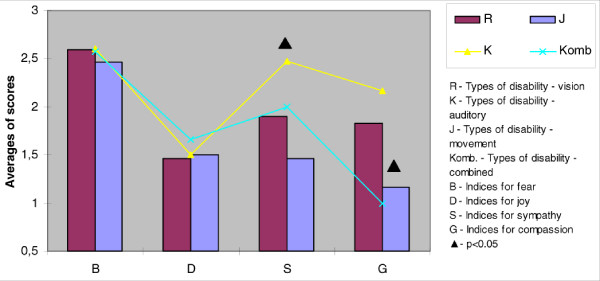
The emotion component of schoolchildren with disabilities according to indices. The indices (fear, joy, sympathy, compassion) of the disabled respondents' emotions towards their peers with disabilities, with relation to the type of disability (vision, movement, auditory, combined).